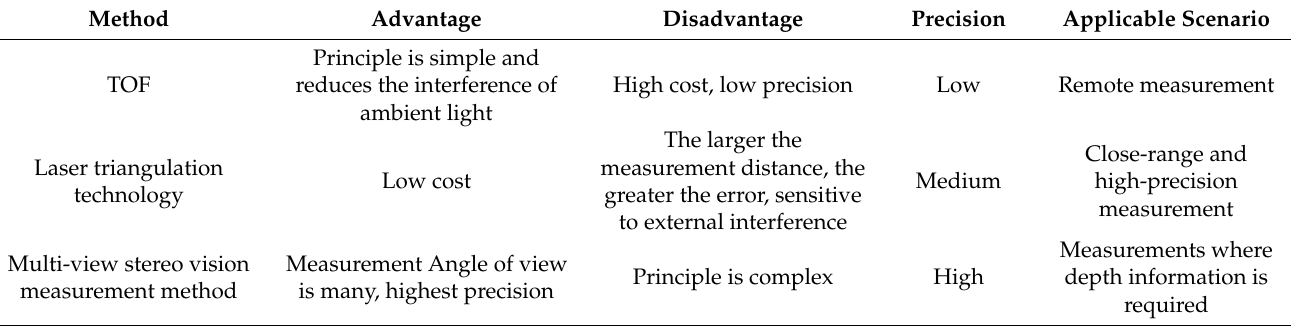
Table 9. Comparison of measurement